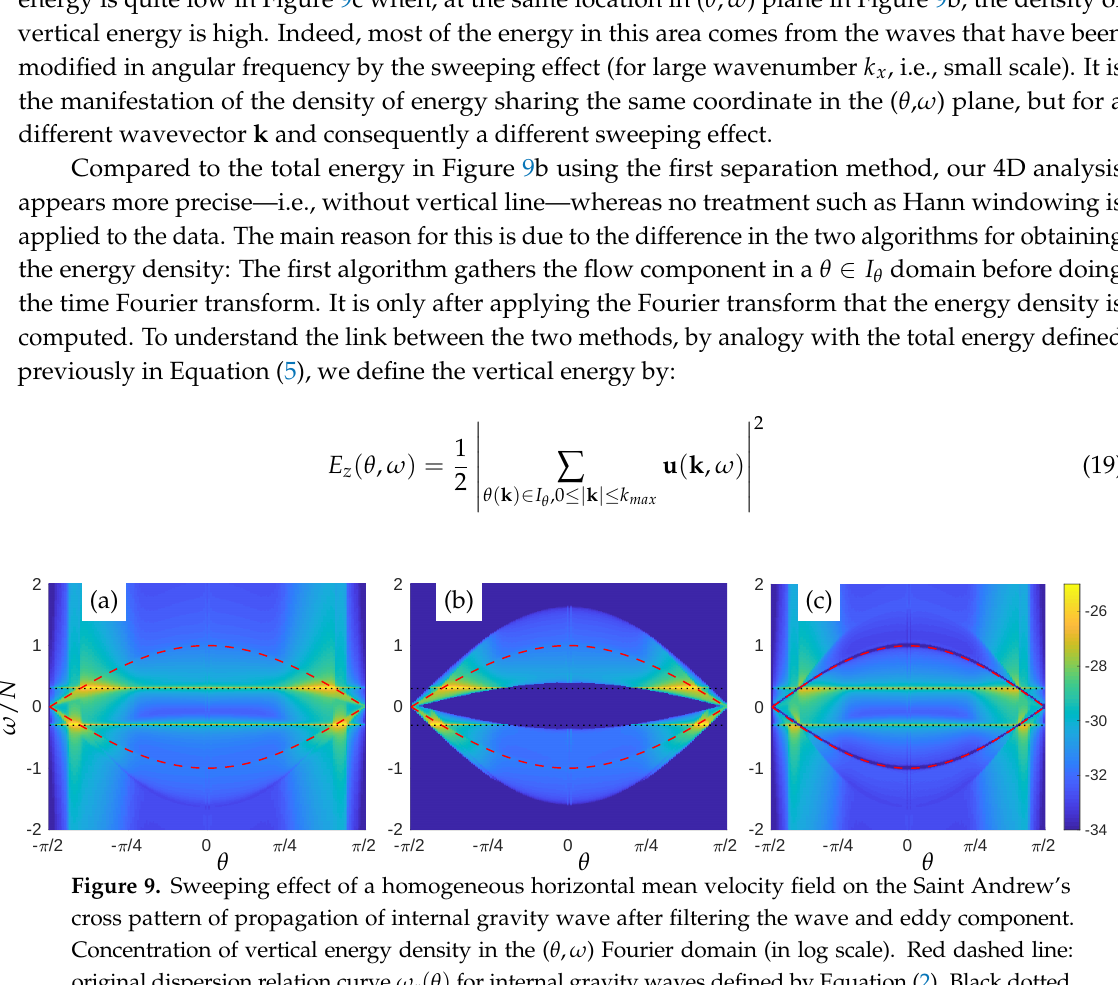
Figure 9. Sweeping effect of a homogeneous horizontal mean velocity field on the Saint Andrew’s cross pattern of propagation of internal gravity wave after filtering the wave and eddy component. Concentration of vertical energy density in the ( θ , ω ) Fourier domain (in log scale). Red dashed line: original dispersion relation curve ω r ( θ ) for internal gravity waves defined by Equation (2). Black dotted line: forcing frequency ω f . ( a ) Full field E (cid:63) z ( θ , ω ) ; ( b ) wave part E (cid:63) , w z ( θ , ω ) ; and ( c ) eddy part E (cid:63) , e z ( θ , ω )